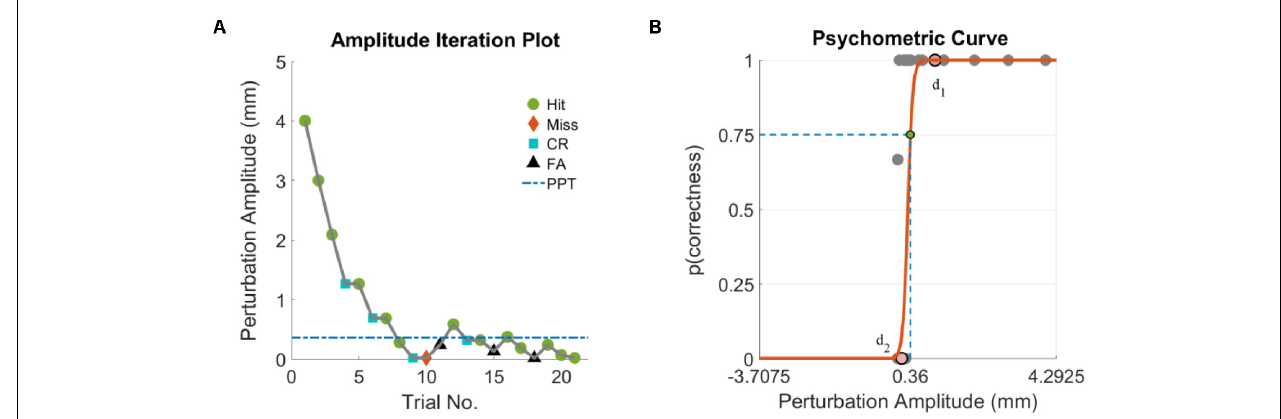
FIGURE 2 | (A) Perturbation amplitude iterations based on a representative subject’s response for a set of PPT assessments and (B) corresponding psychometric curve with PPT shown by the green circle. Points d 1 and d 2 represent the median of perturbation amplitudes that were successfully detected ( p = 1) and not detected ( p = 0), respectively. HIT, perturbation presented and correctly reported; MISS, perturbation presented but not reported; Correct Rejection (CR), perturbation not presented and not reported; False Alarm (FA), perturbation not presented but